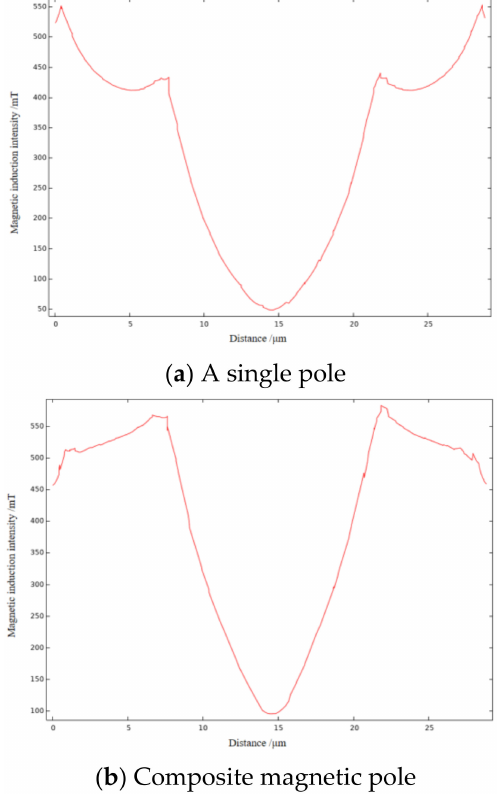
Figure 5. Magnetic induction intensity curve of two MAF